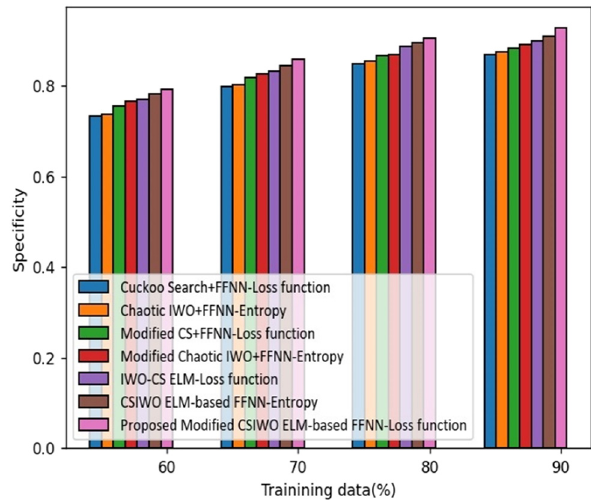
Figure 7: Analysis based on objective value function - based speci fi city.